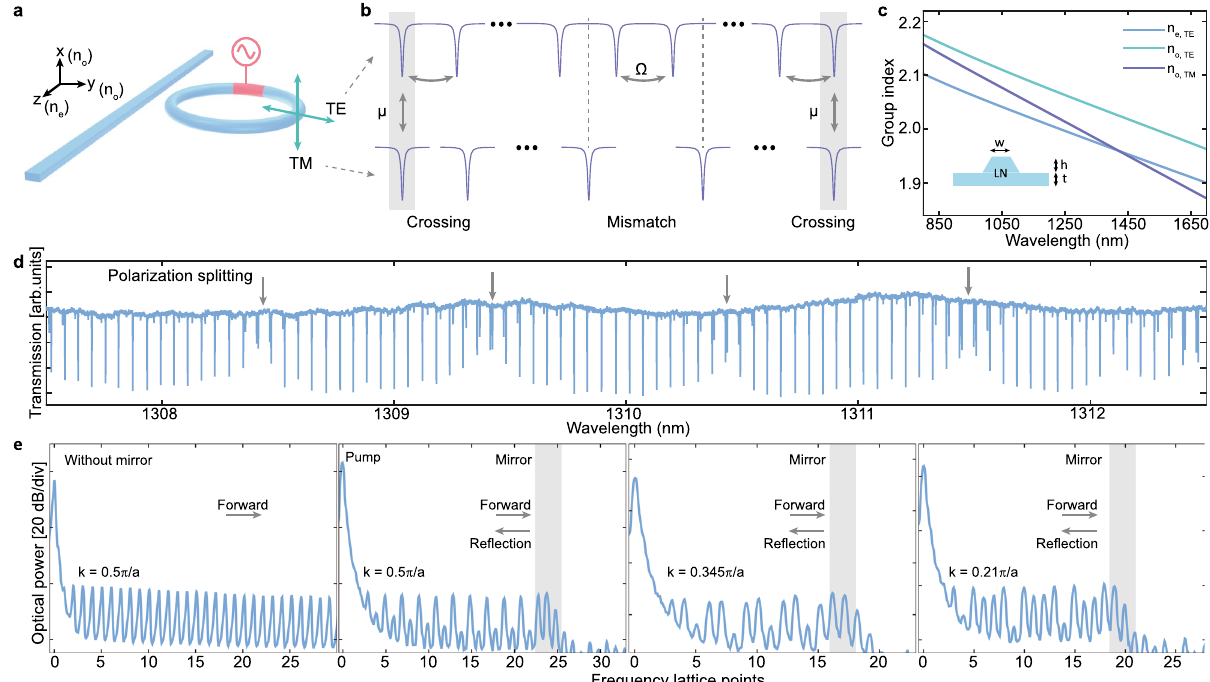
Fig.3|Re fl ectioninducedinterferenceinthefrequencysyntheticcrystalusing polarization coupling. a On the x-cut thin- fi lm lithium niobate, TE mode that propagates along the y- and z-direction has different indexes n o , TE and n e , TE , while the TM mode has index of n o , TM for all directions. Dispersion engineering can be used to make the indices of TE and TM modes degenerate, leading to strong coupling μ between TE and TM resonances. b The frequency mirrors induced by mode-splitting only happens when the TE and TM modes have both index and frequencydegeneracy.DifferenceinFSRofTEandTMmodes,guaranteesthatthey frequency overlaps at some frequencies, leading to formation of periodic fre- quency mirrors. c The group index n o , TM can be designed to be between the n o , TE and n e , TE via dispersion engineering. Then, TE mode circulating inside a x-cut lithium niobate resonator, it experiences different averaged indices (ranging from n e n o , TE to , TE ) at different bending points of the resonator. As a result, index degeneracy between TE and TM modes can be achieved over a broad